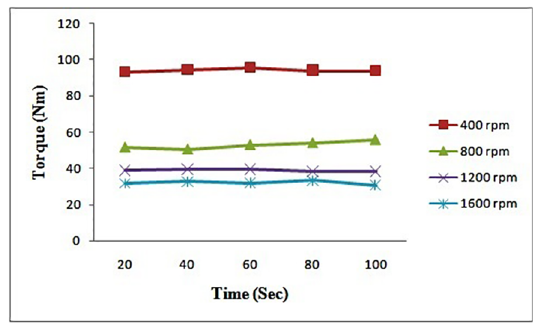
Figure 7. Torque on the welds with water head of 30 mm and tool rotational speed rates of 400, 800, 1200 and 1600 rpm